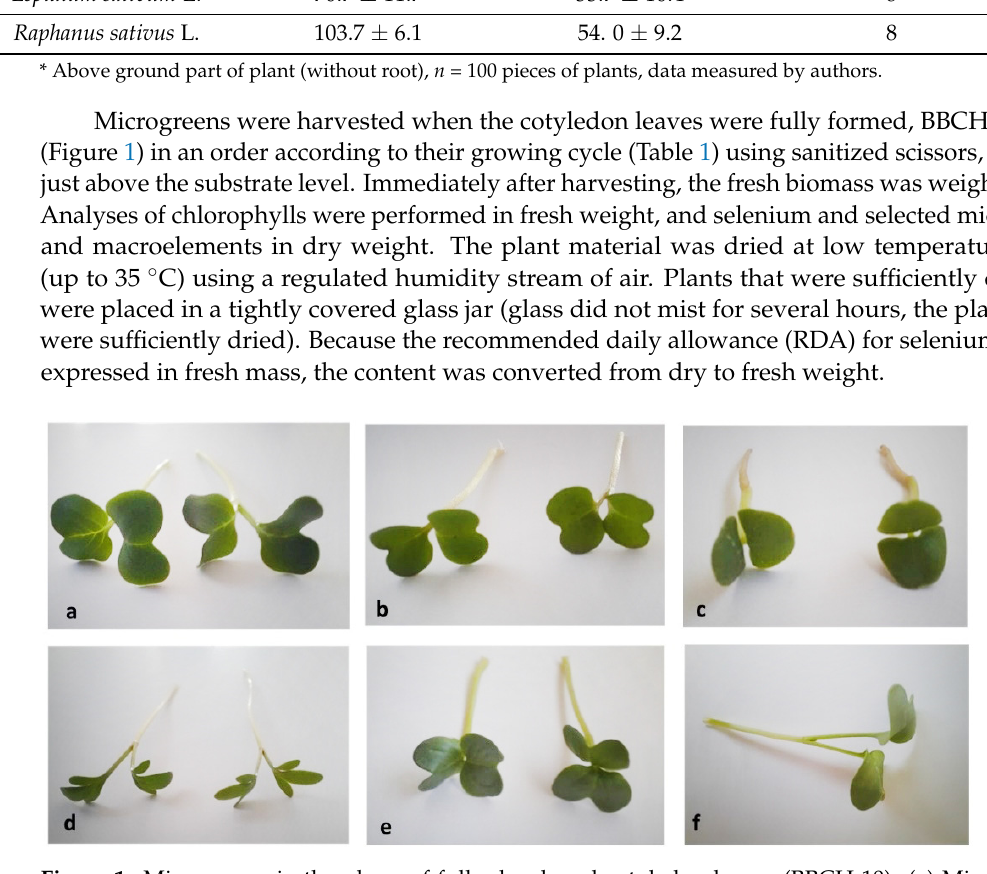
Figure 1. Microgreens in the phase of fully developed cotyledon leaves (BBCH 10): ( a ) Mizuna, ( b ) Arugula, ( c ) Green Basil, ( d ) Cress, ( e ) Radish, ( f ) the appearance of the first true leaf in mizuna.